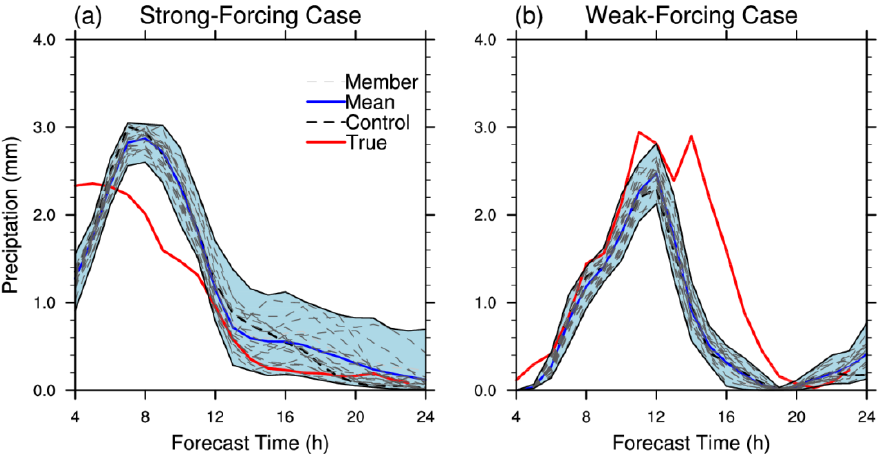
Figure 7. The time series of regional average precipitation in the ( a ) SF case and ( b ) WF case (red solid line: observation; black dotted line: control experiment; blue solid line: the result of ensemble mean; gray dotted line: ensemble member forecast).